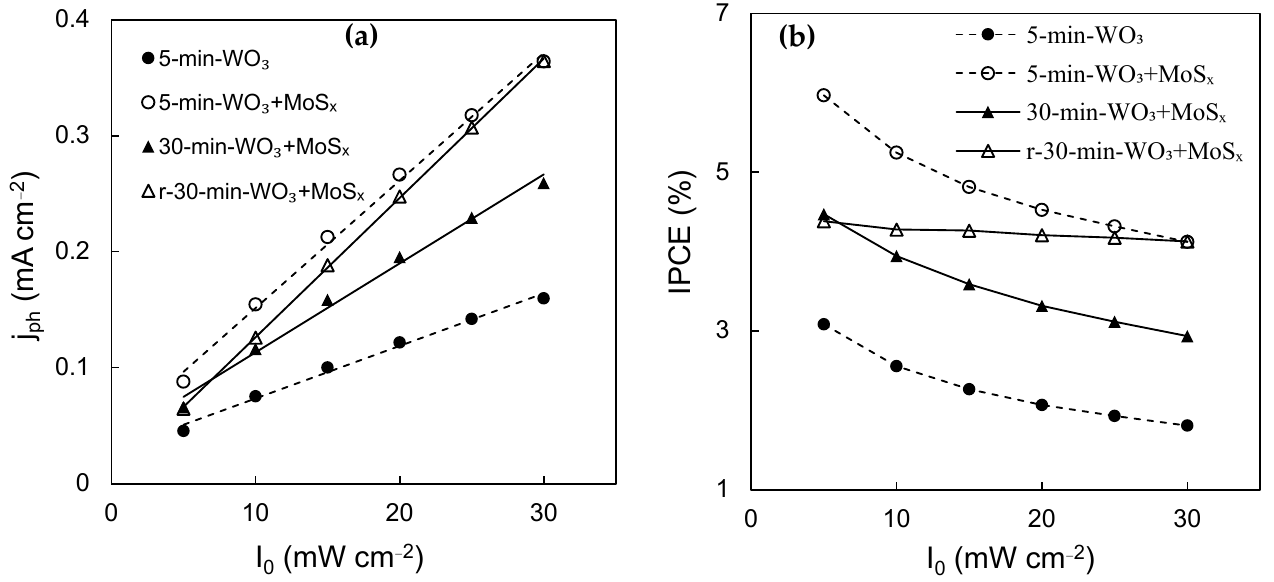
Figure 9. Values of photocurrents generated by WO 3 , WO 3 /MoS x , and reduced WO 3 /MoS x films at 1.53 V and under different light intensities ( a ); IPCE (%) values calculated from photocurrents ( b ).